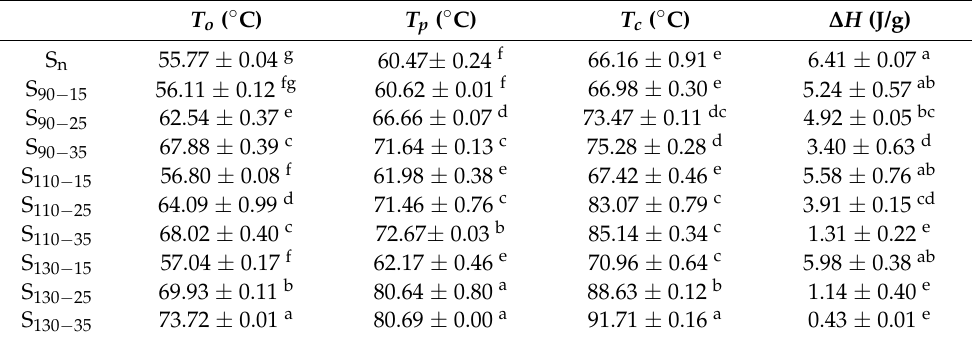
Table 2. Thermal properties of native and HMT HB flours. T o ( ◦